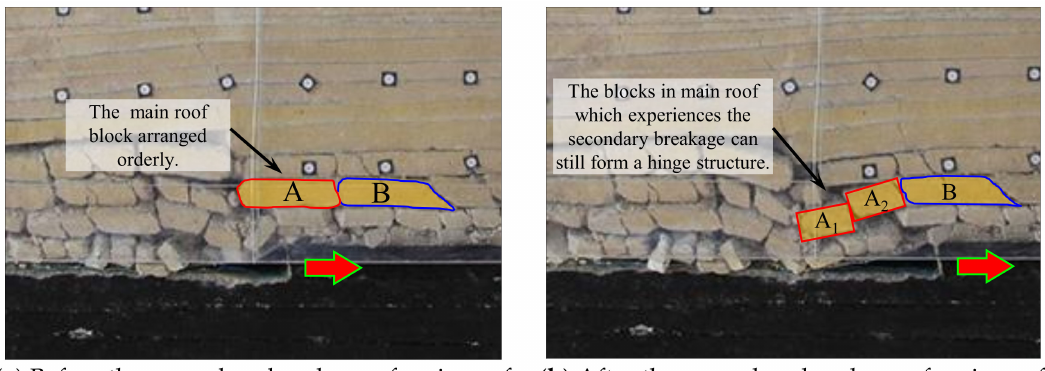
Figure 6. The secondary breakage process of the main